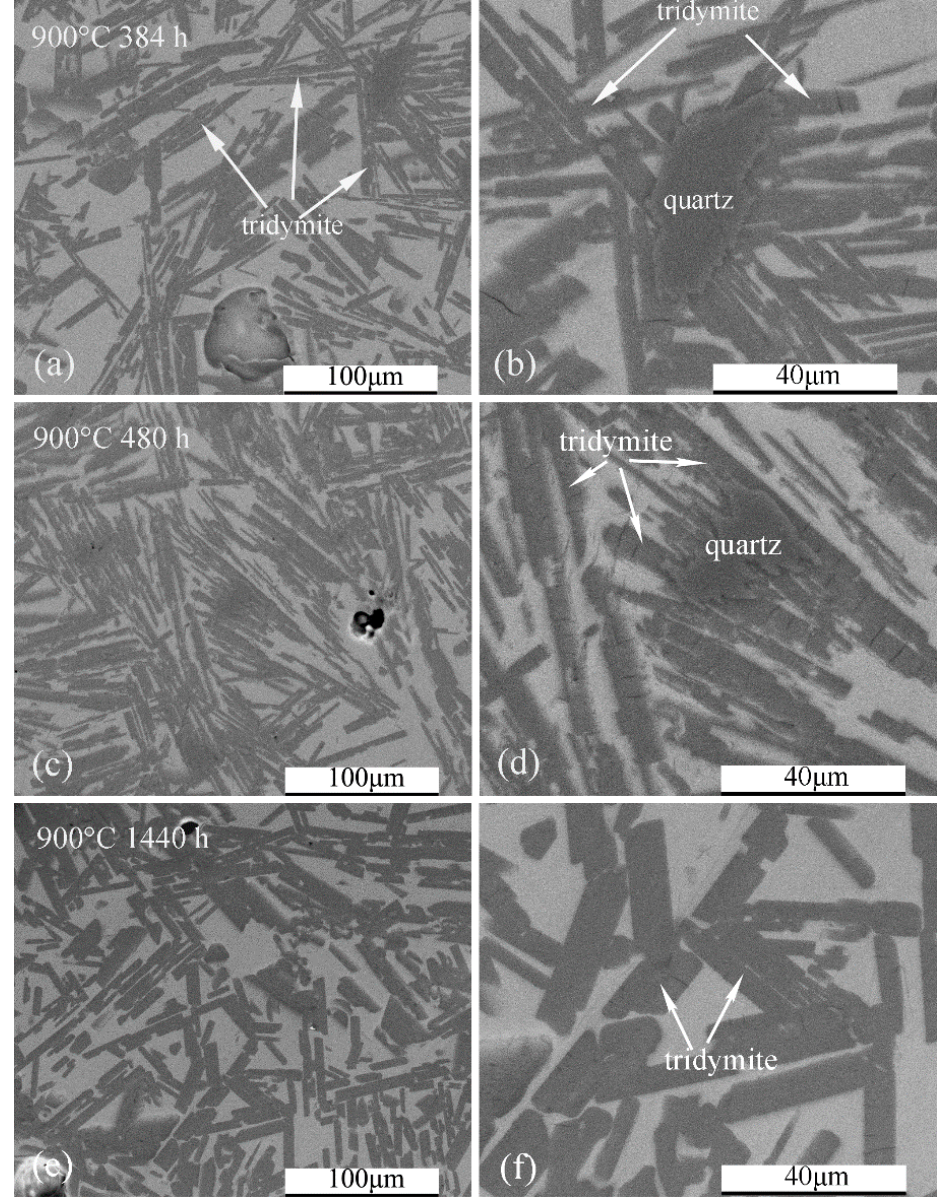
Figure 9. Microstructure of the coarse quartz—potassium silicate glass composites after holding at 900 °C for different time: 384 h ( a , b ), 480 h ( c , d ) and 1440 h ( e , f ).